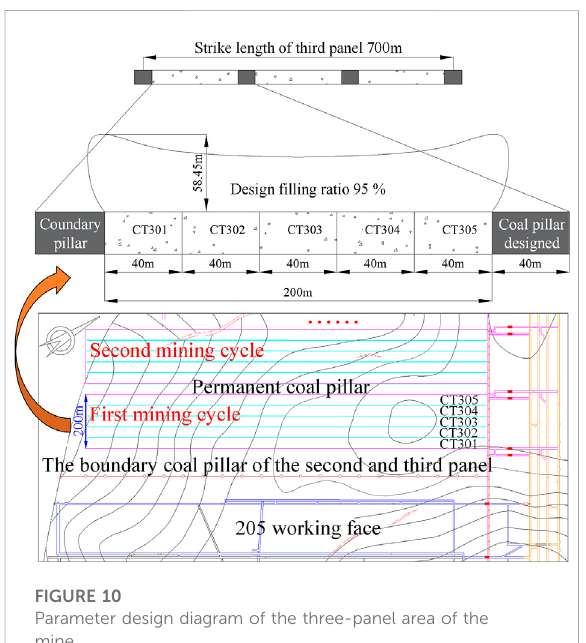
FIGURE 10 Parameter design diagram of the three-panel area of the